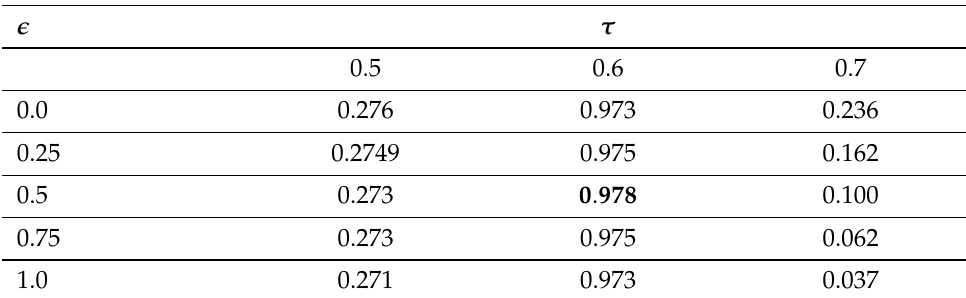
Table 2. F1-scores of ABIForest consisting of T = 150 trees as a function of the hyperparameters τ and (cid:101) for the Circle dataset with ω = 20.